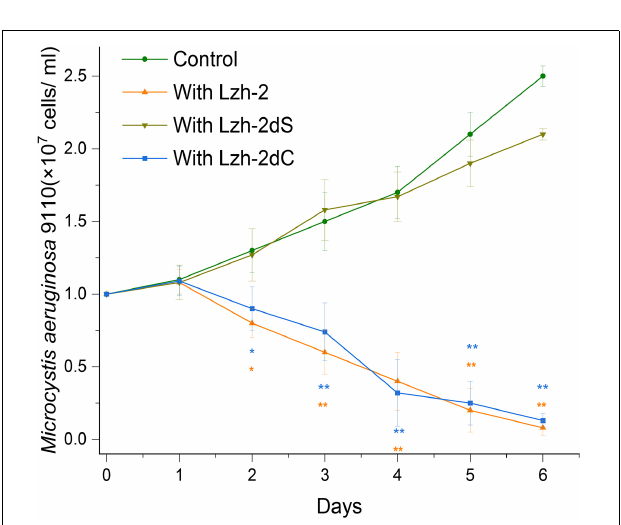
FIGURE 3 | Dynamics of cell density of Microcystis aeruginosa 9110 co-cultured with or without Shewanella xiamenensis strains (1:1). Control without co-cultures (Green); co-cultured with strain Lzh-2 (orange); co-cultured with strain Lzh-2dS (dark yellow); co-cultured with strain Lzh-2dC (blue). * and ** represent p < 0.05 and p < 0.01 comparing to the control group, respectively.